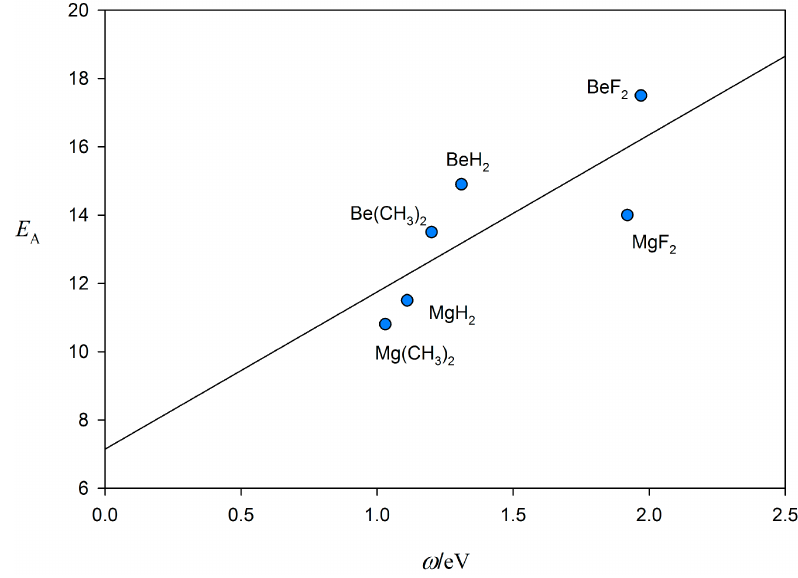
Figure 10. The relationship between the conceptual DFT electrophilicity index, ω , calculated from Equation (2) at the CCSD/aug-cc-pVTZ//CCSD(T)/aug-cc-pVTZ level of theory, and the E A determined here for various MR 2 molecules (M = Be or Mg, R = F, H, or CH 3 ).